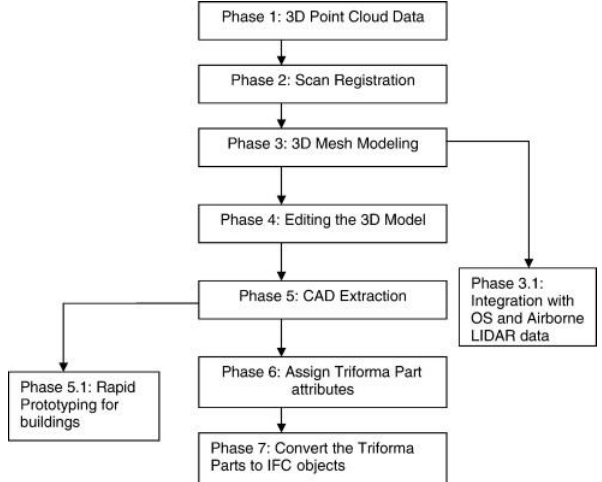
Figure 5. The methodology of the point cloud data capture, processing and modeling (adopted from Y. Arayici, 2007).